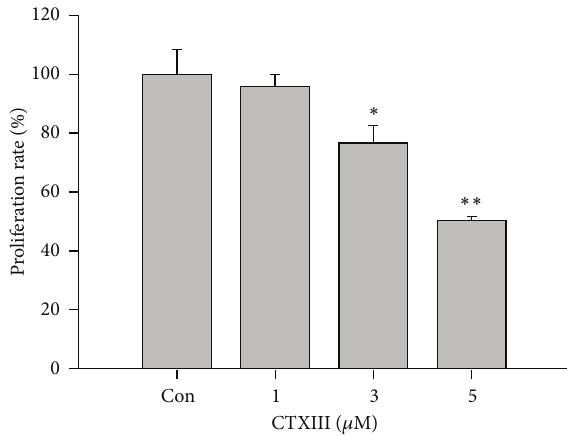
Figure 1: Inhibitory effect of CTXIII on proliferation of Ca9-22 cells. Cells were incubated with indicated concentrations of CTXIII (from 0, 1, 3, and 5 𝜇 g/mL) for 24 h. The proliferation inhibition was determined by trypan blue exclusion assay. Data, means ± SD ( 𝑛 = 3 ). ∗ 𝑃 < 0.05 and ∗∗ 𝑃 < 0.001 for control versus CTXIII- treated,